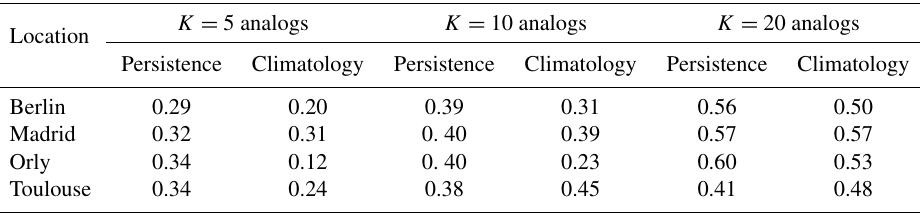
Table 2. CRPSS versus persistence and climatology for SWG simulations with 5, 10, and 20 analogs for the [30 ◦ W–20 ◦ E; 40–60 ◦ N] domain and for a lead time of